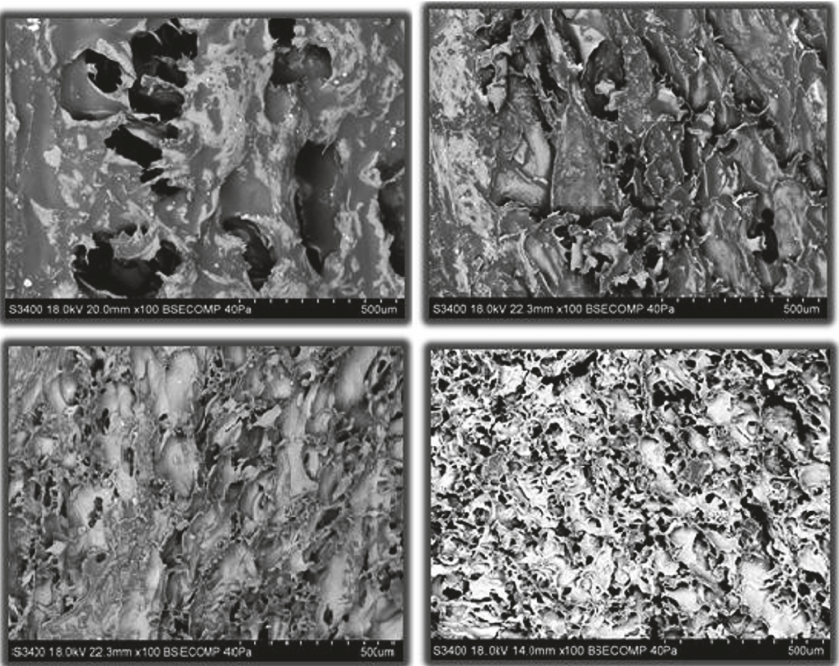
Figure 5: Effect of freezing rate on the microstructure of salmon. Photo micrographs of surface pore. Top left: -7 ∘ C(-7 ∘ C) corresponds to a treatment frozen at in the -7 ∘ C unit to a core temperature of -7 ∘ C. Top right: -18 ∘ C(-7 ∘ C) corresponds to a treatment frozen in the -18 ∘ C unit to a core temperature of -7 ∘ C. Middle left: -29 ∘ C(-7 ∘ C) corresponds to a treatment frozen in the -29 ∘ C unit to a core temperature of -7 ∘ C. Middle right: -106 ∘ C(-7 ∘ C) corresponds to a treatment frozen in the -77 ∘ C to a core temperature of -7 ∘ C. (Figure 5 is reproduced from [22] [under the Creative Commons Attribution License/public domain]).